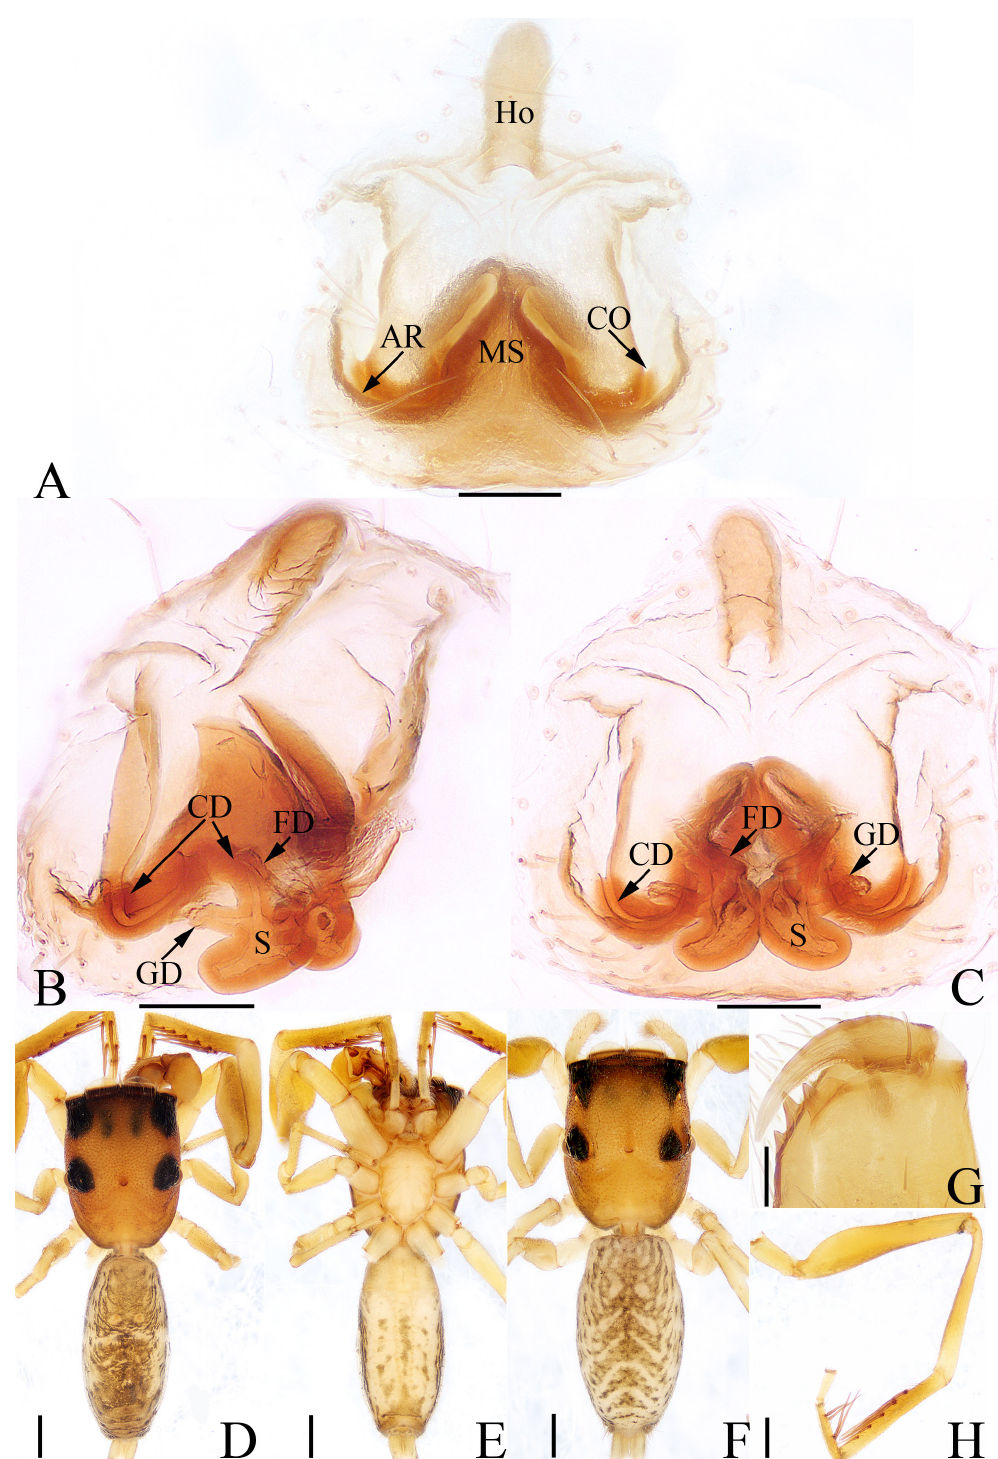
Fig. 4. Synagelides forkiforma Yang, Zhu & Song, 2007. A–C, F . ♀ (HNU-20040428-02). D–E, G–H . ♂ (HNU-20040428-01). A . Epigyne, ventral view. B . Epigyne, dorsolateral view. C . Epigyne, dorsal view. D . Habitus, dorsal view. E . Habitus, ventral view. F . Habitus, dorsal view. G . Chelicerae, dorsal view. H . Leg I, prolateral view. Abbreviations: see Material and methods. Scale bars: A–C, G = 0.1 mm; D–F, H = 0.5